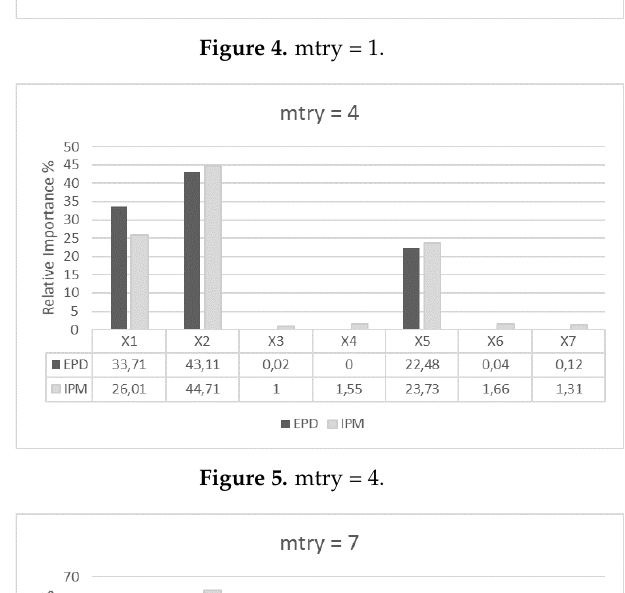
Figure 5. mtry = 4.